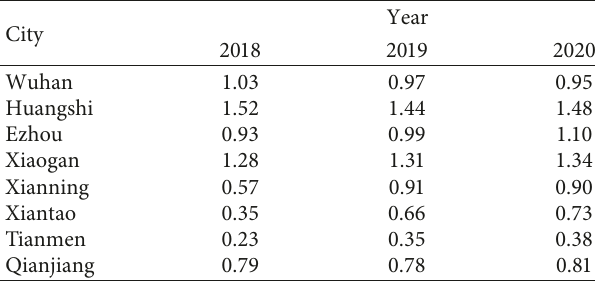
Table 2: Concentration level of talent elements in the Wuhan city circle, 2018–2020.